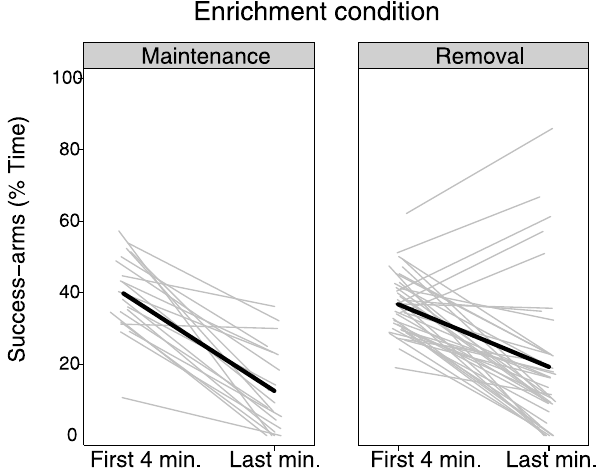
Figure 2. Percentage of time in the success-arms by enrichment condition. Though both groups spent significantly less time in the success-arms after the ambiguous-arms became available, ps , .001, the decrease was significantly greater in the enrichment-maintenance group than the enrichment-removal group, p , .05 (light gray lines: individual responses; thick black lines: average response by condition).